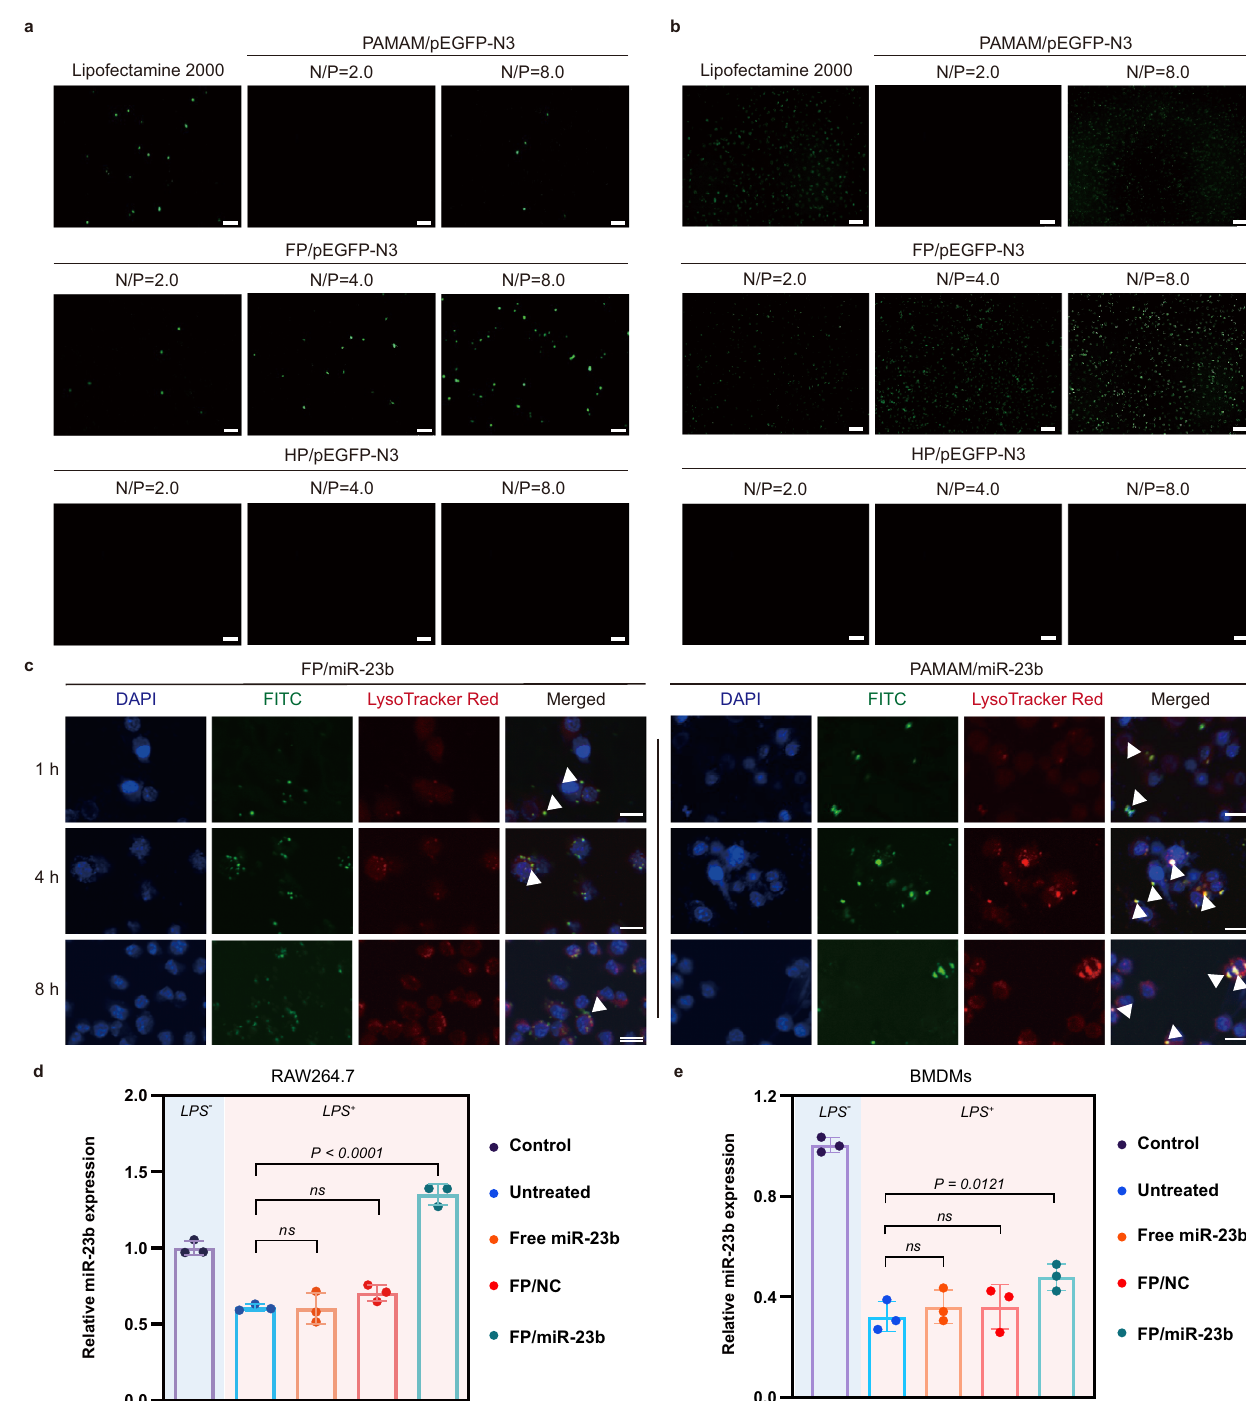
Fig.2|Invitrotransfectionef fi ciencyanalysisofFP.a , b Fluorescenceimagesof the carriers-mediated transfection of pEGFP-N3 in LPS-stimulated BMDMs ( a ) and RAW264.7 cells ( b ) for 48h. Lipofectamine 2000 was served as the control. Scale bar: 100 μ m. c The representative images of the carrier-mediated miR-23b trans- fectioninLPS-stimulatedRAW264.7cells.Nuclei,blue(DAPI);FPorPAMAM,green (FITC); lysosomes, red (LysoTracker Red). The white arrows represent the overlap ofgreenandred fl uorescence,indicatingthatthenanoparticleswereentrappedin